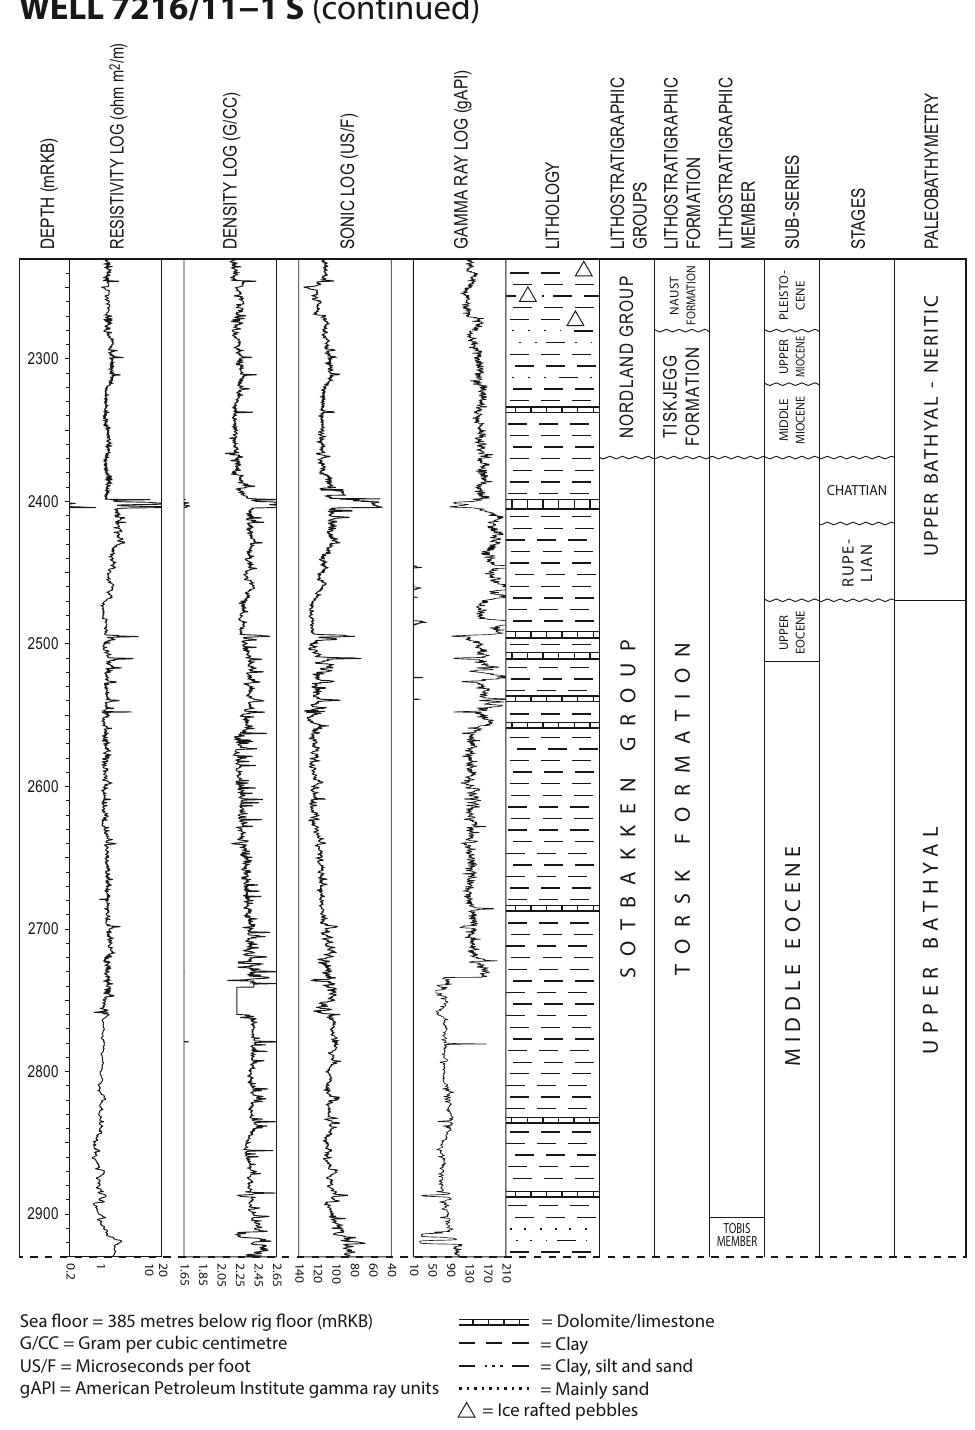
= Dolomite/limestone pebbles= Clay = Clay, silt and sand = Mainly sand = Ice rafted Figure 10. Well summary figure for well 7216/11–1 S including resistivity log, density log, sonic log, gamma-ray log, lithology, lithostratigraphic units, sub-series, stages and paleobathymetry for the upper part of the supplementary well reference sections for the Torsk Formation and the type sections for the Tiskjegg Formation and the Tobis Member (upper part) (middle Eocene to upper Miocene; modified after Ryseth et al., 2003;